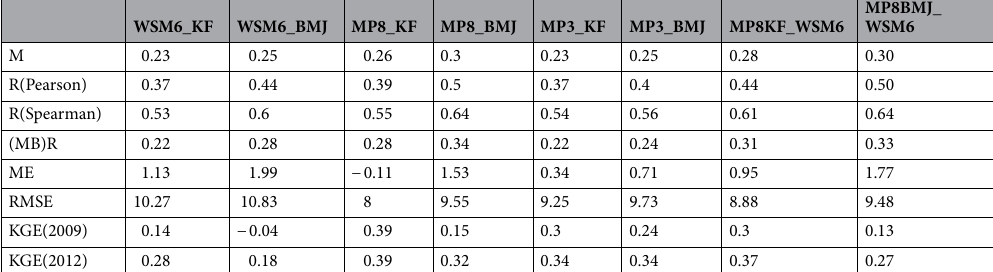
Table 3. Performance metrics for ANN of the simulations with observation.